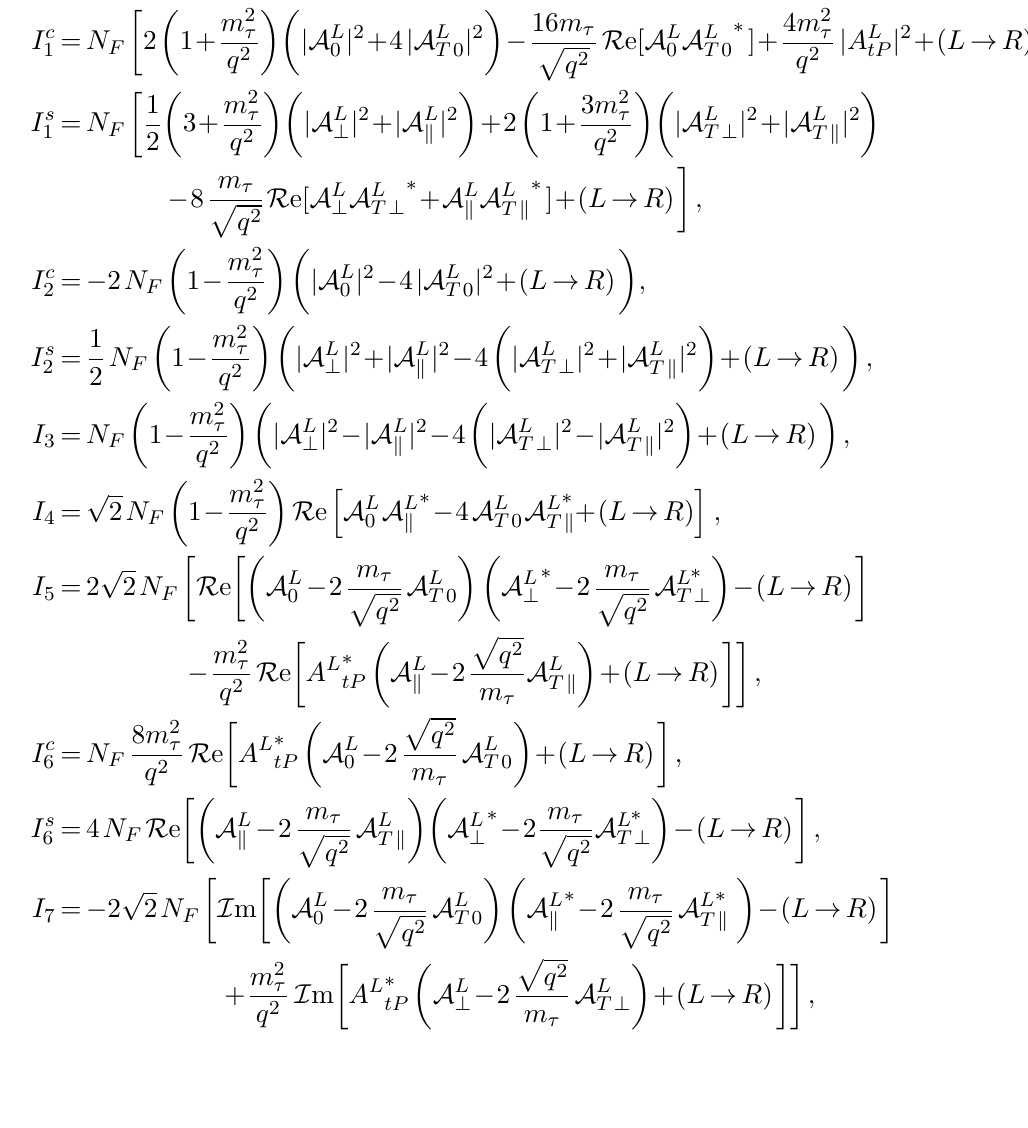
where B ( D (cid:3) ! D (cid:25) ) is the branching fraction of the D (cid:3) decay into D (cid:25) states described